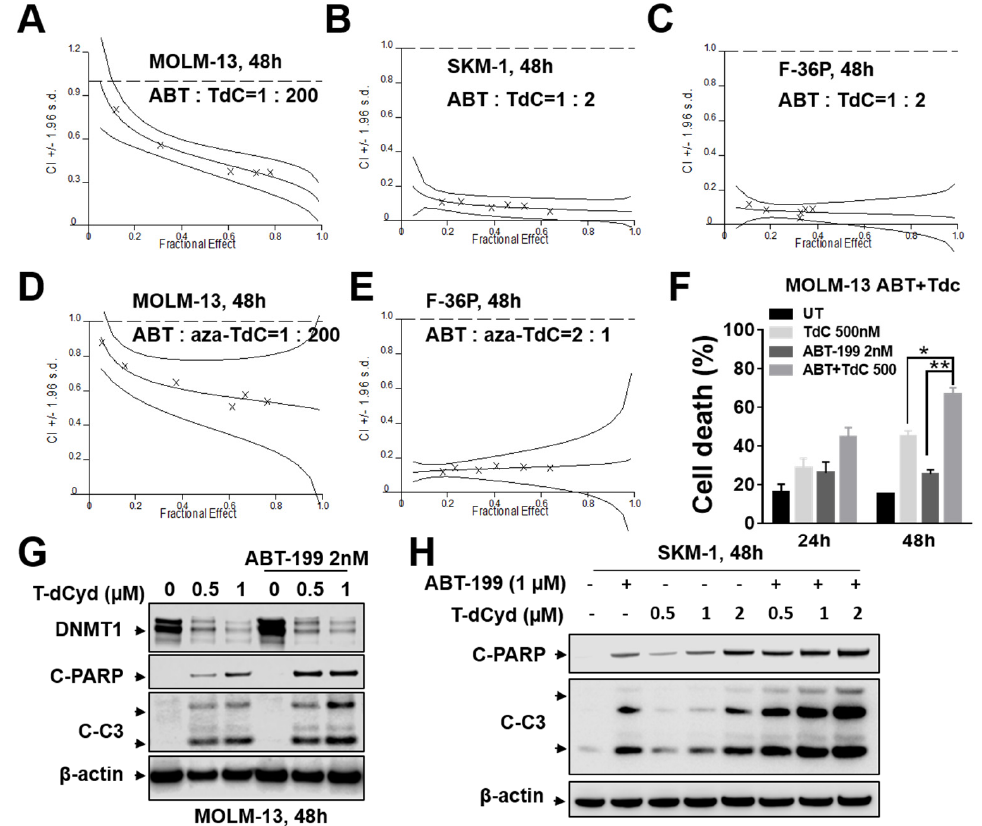
Figure 1. MDS–derived MOLM–13 and MDS SKM–1 and F–36P cells were exposed to varying concentrations of ABT–199 and T–dCyd or Aza–T–dCyd administered at a fixed ratio for 48 h, after which Median Dose Effect analysis was used to characterize concentration index (CI) values in relation to the fraction affected (FA). CI values < 1.0 denote synergistic interactions ( A – E ). ( F ) Cell death was monitored by Annexin V/PI staining and FCM. For p values, * = <0.05; ** = <0.01. ( G , H ) Cleaved PARP, caspase 3, and DNMT1 were detected by WB in MOLM–13 and SKM–1 cells exposed to T–dCyd ± ABT–199; β -actin controls are shown to document equivalent loading and